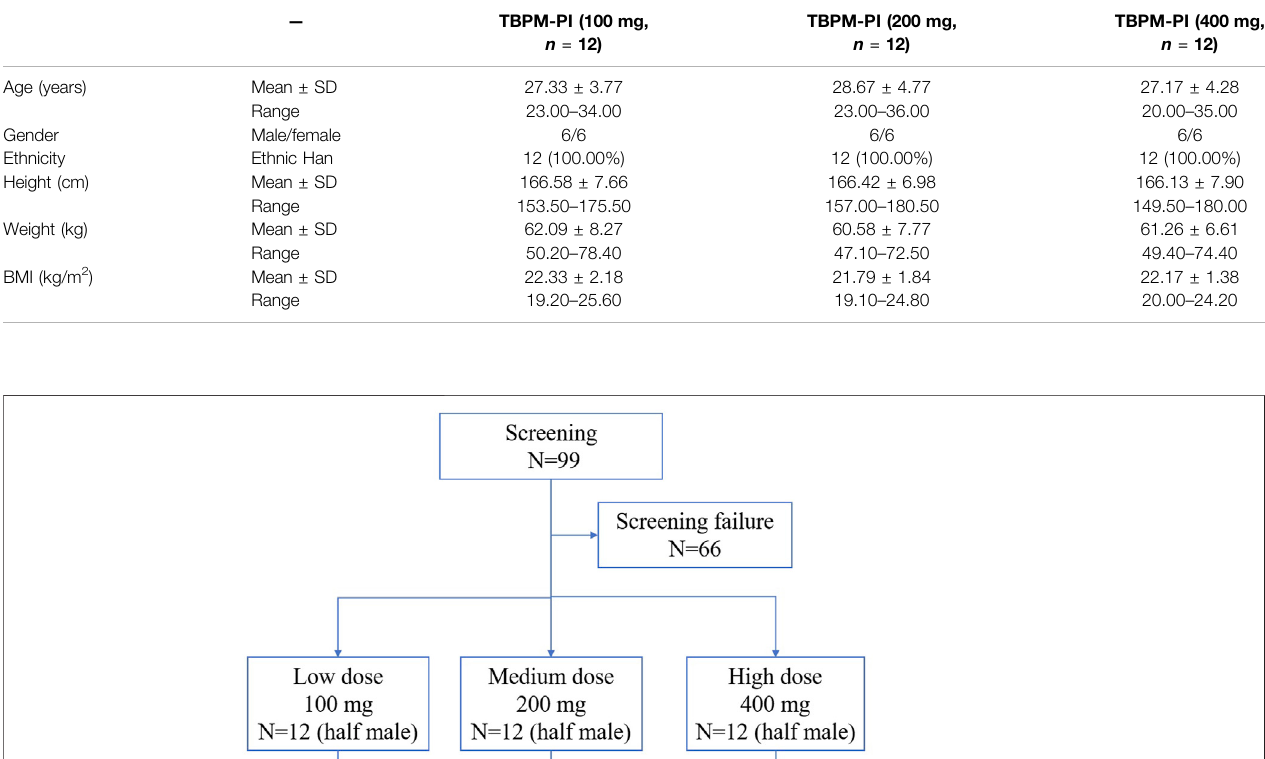
TABLE 1 | Baseline characteristics of subjects included in the pharmacokinetic analysis population.